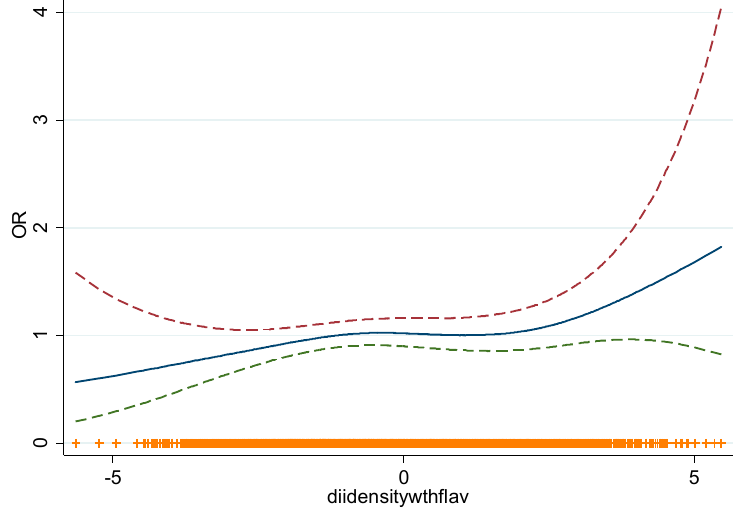
Figure 2. Generalised additive model of the association between E-DII and CLL ( p = 0.18). Blue line: Spline; Dotted lines: 95% confidence interval. X-axis: